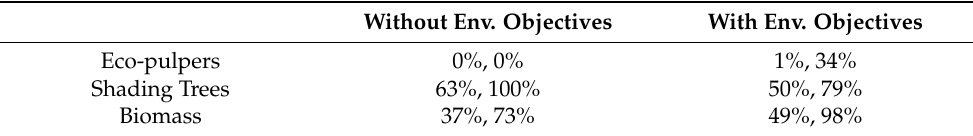
Table 4. Optimization choices when running the model with only budget and physical constraints and when adding environmental objectives. The first percentage represents the budget allocation while the second compares the amount invested with the maximum possible level of investment. Without Env. Objectives With Env. Objectives Eco-pulpers 0%, 0% 1%, 34% Shading Trees 63%, 100% 50%, 79% Biomass 37%, 73% 49%,